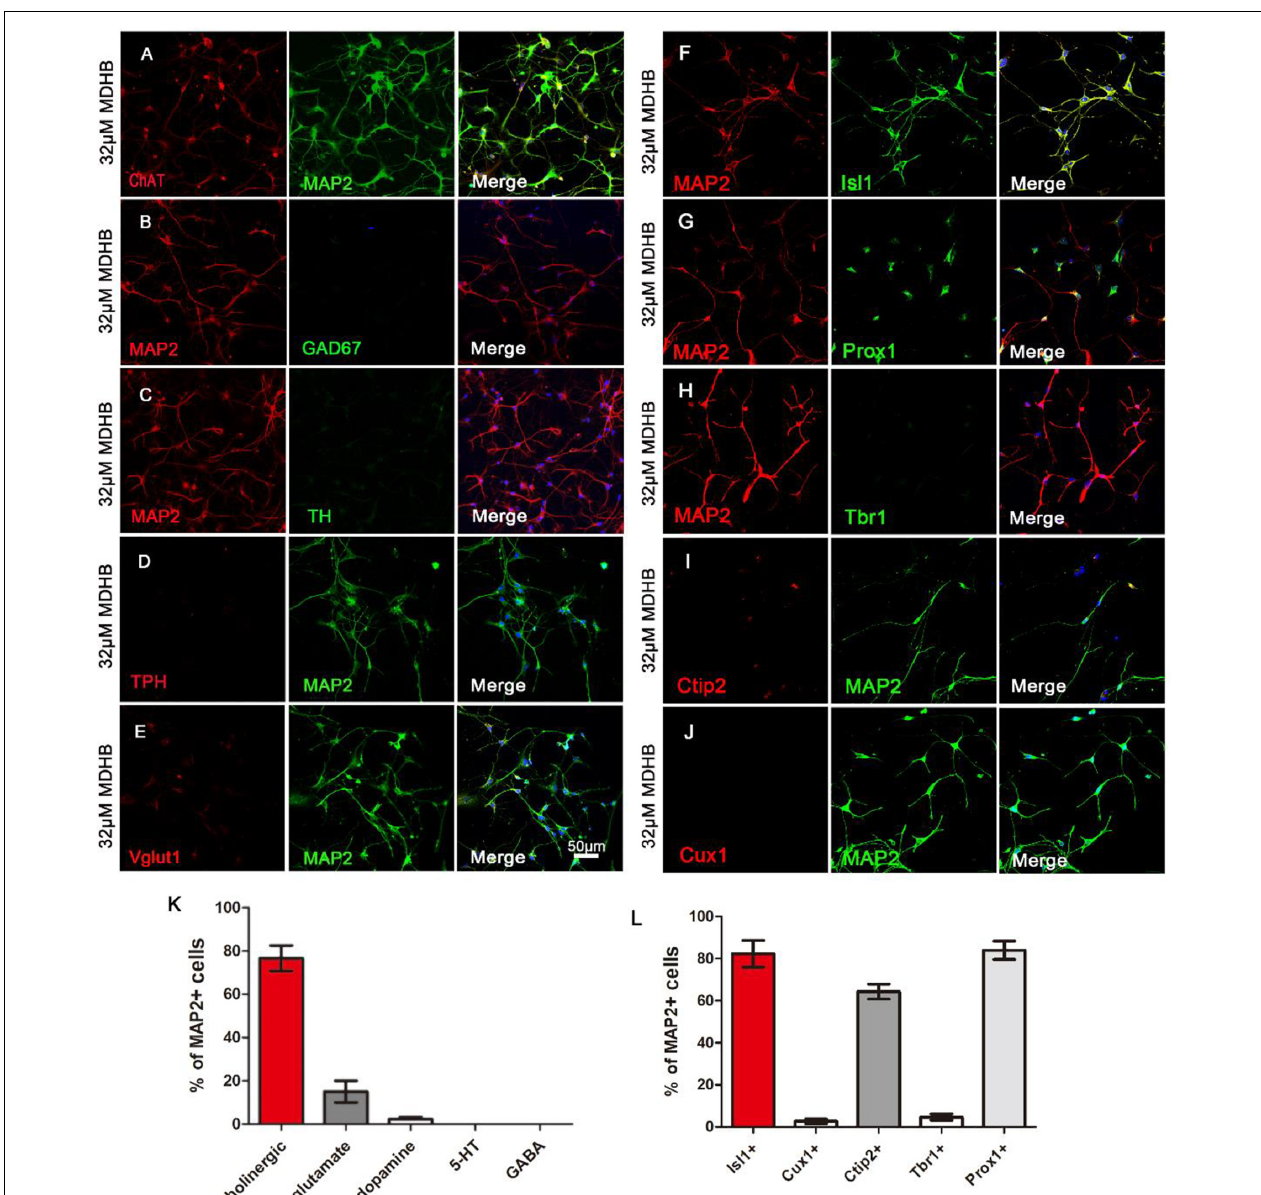
FIGURE 4 | The types analysis of MDHB-induced neurons. (A) The cholinergic neurons with ChAT and MAP2 were respectively dyed red and green; (B) the GABAergic neurons with MAP2 and Gad67 were respectively dyed red and green; (C) the dopaminergic neurons with MAP2 and TH were respectively dyed red and green; (D) the serotonergic (5-HT) neurons with TPH and MAP2 were respectively dyed red and green; (E) the glutamatergic neurons with Vglut1 and MAP2 were respectively dyed red and green; (F) MDHB-induced neurons were also immunopositive for motor neuron marker Isl1; (G,H) Immunostaining with neuron markers revealed that MDHB-induced neurons were negative for general cortical neuron marker Tbr1, but positive for hippocampal neuron marker Prox1 (G) ; (I,J) Immunostaining with neuron markers revealed that MDHB-induced neurons were negative for superficial layer marker Cux1 (J) , but positive for deep layer marker Ctip2 (I) . (K,L) The statistical results showed that MDHB promoted NSCs differentiation into hippocampal cholinergic